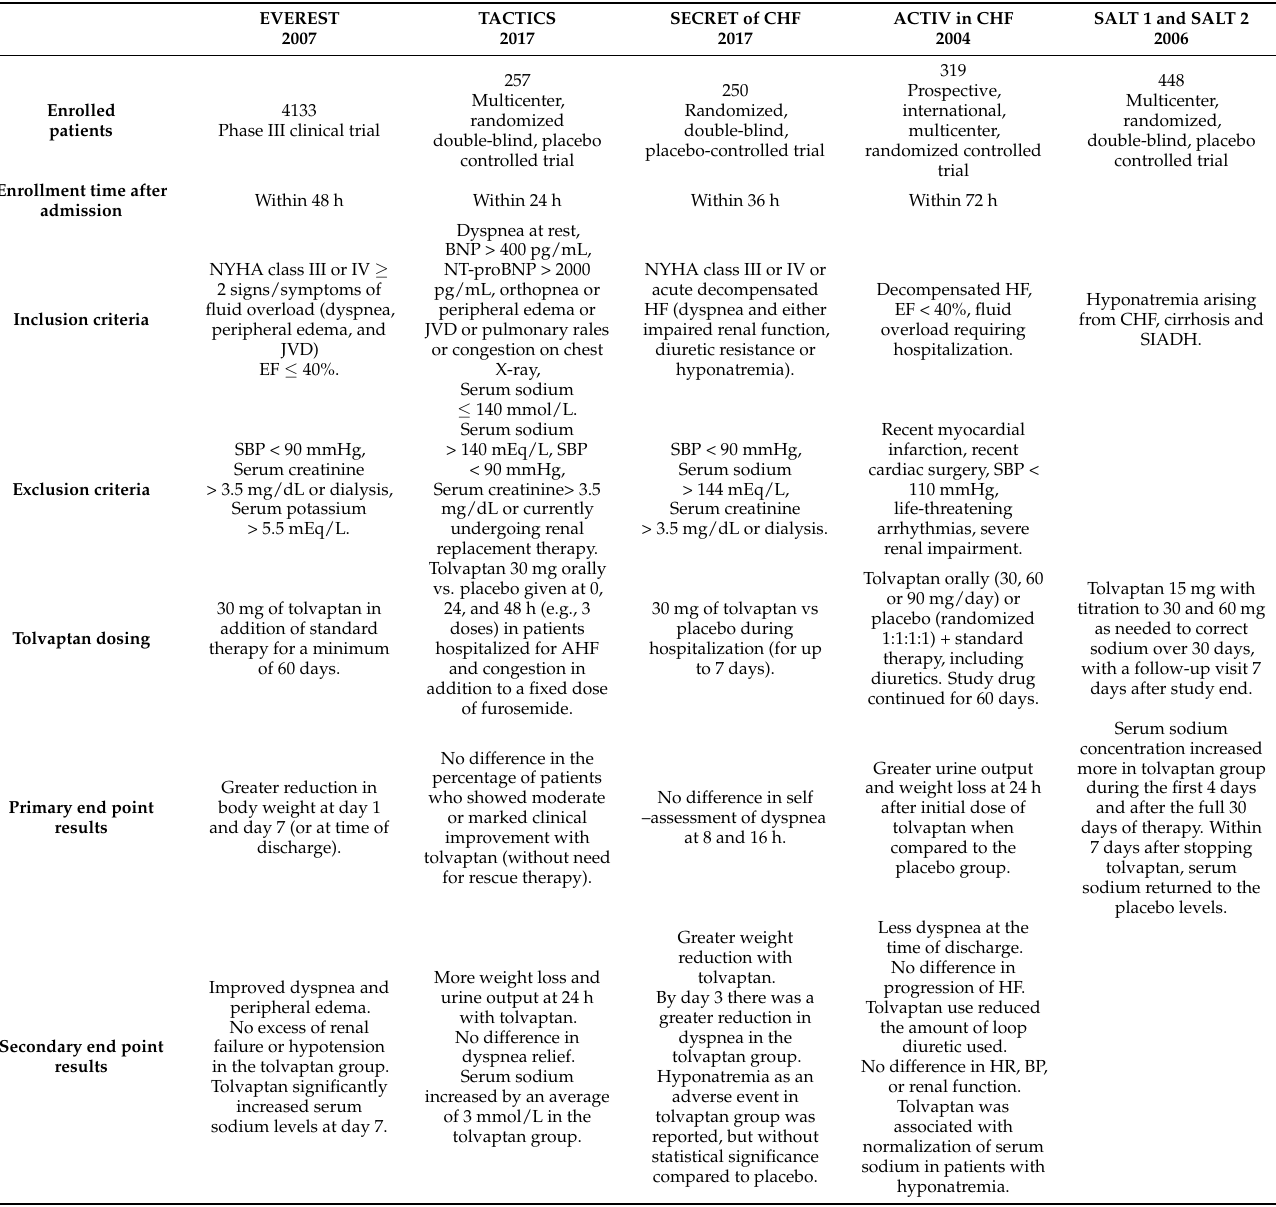
Table 4. Studies of tolvaptan versus placebo in heart failure and sodium evaluation